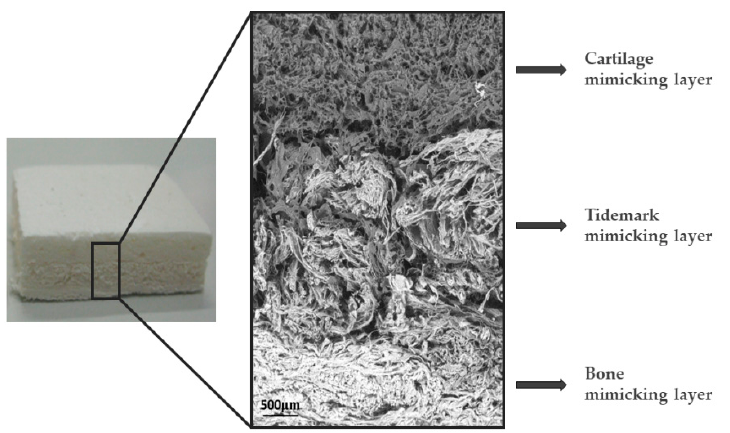
Figure 3. Three-dimensional hybrid scaffolds by bio-inspired mineralization processes for regeneration of osteocartilaginous tissues ( left ) and SEM micrograph showing multi-layered structure ( right ). As natural polymers are easily subjected to fast enzymatic dissolution, the resorptive properties of hybrid scaffolds can be modulated using specific cross-linking additives, such as 1,4-butanediol diglycidyl ether (BDDGE), genipin or ribose, which are suitable for modulating the strength of interfibrillar bonds and in turn, the bioresorbability,